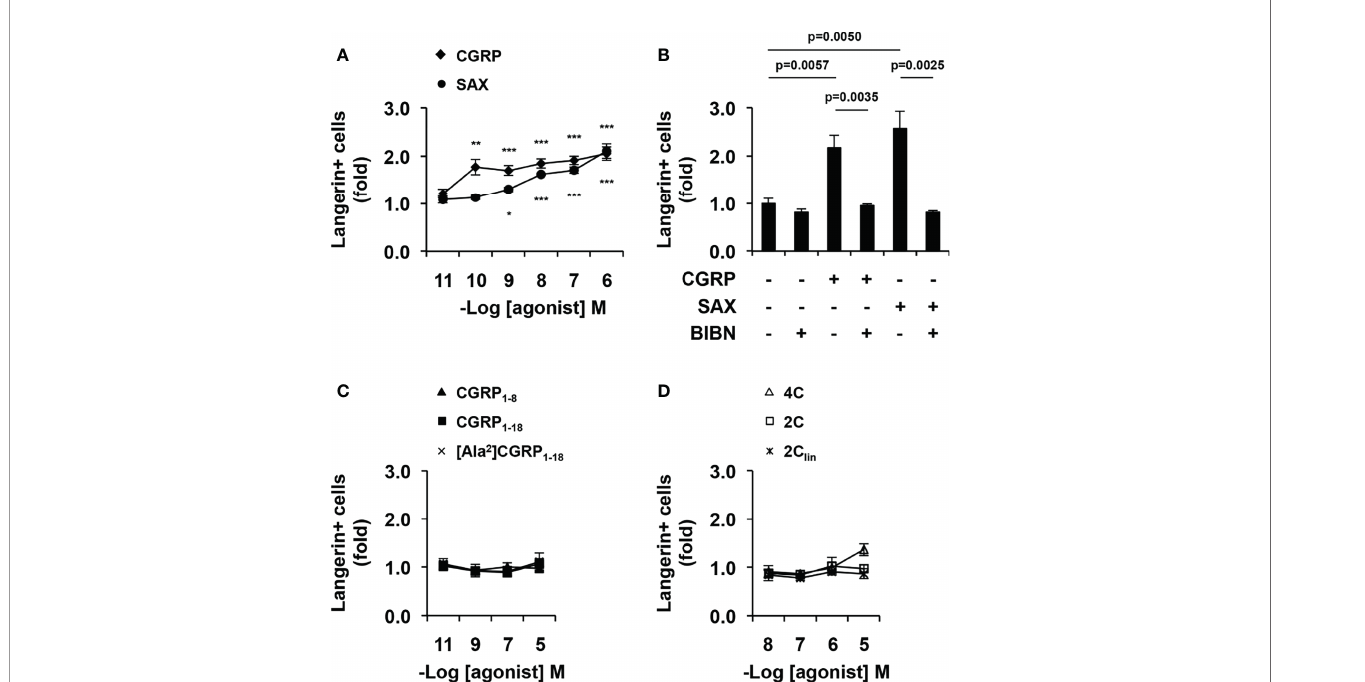
FIGURE 4 | CGRP and SAX, but not CGRP peptide fragments, increase langerin expression in MDLCs. MDLCs were left untreated or treated for 24 h with the indicated molar concentrations of CGRP, SAX or CGRP peptide fragments. In panel (B) , the CGRP receptor antagonist BIBN4096 (BIBN, 1 m M) was added 15 min before addition of agonists (0.1 m M). The cells were then stained for surface langerin and examined by fl ow cytometry. Shown are mean ± SEM folds increase in the percentages of langerin+ cells, derived from n = 5 (A, C) , n = 4 (B) and n = 3 (D) independent experiments using MDLCs from different individuals. *p < 0.0500, **p < 0.0050, ***p < 0.0005, two-sided Student ’ s